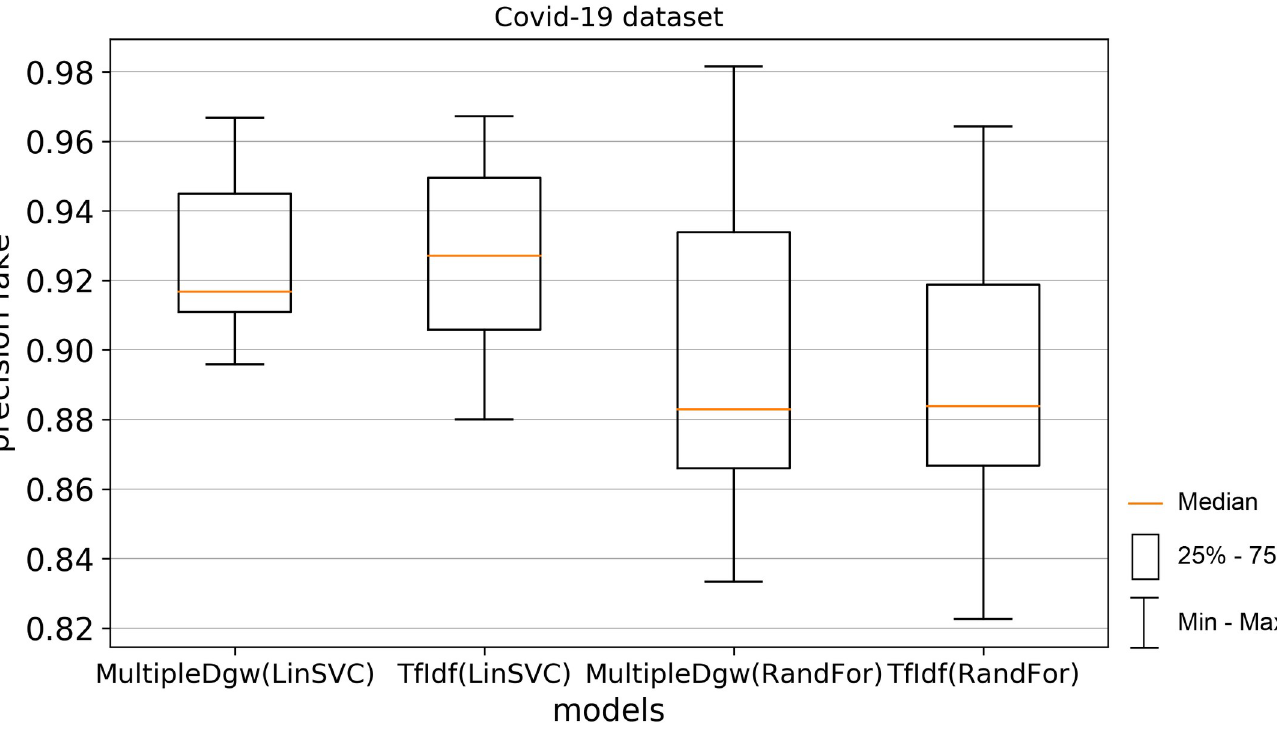
PLOS ONE | https://doi.org/10.1371/journal.pone.0256940 September 14,